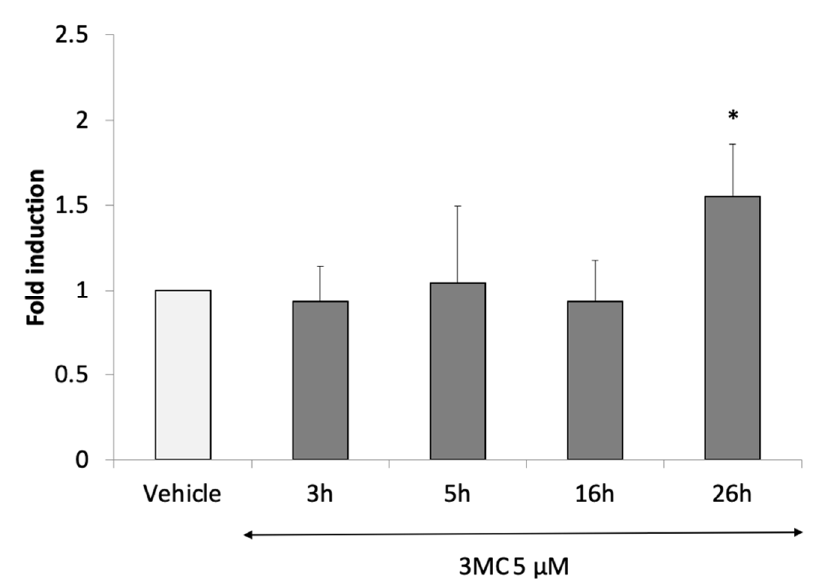
Figure 6. Time course of 3MC, a positive modulator of AHR-1 in Cos-7 cells. After transfection and culture for 24 h in 0% FBS medium, cells were treated for 24 h with 3-methylcholanthrene 5 µ M. After 3 h, 5 h, 16 h and 26 h of treatment, cells were lysed, and Firefly luciferase luminescence was read. Six independent experiments were performed in duplicate, error bars represent SD, fold induction is standardized to the vehicle which is 1. Statistical significances relative to the vehicle were examined: ANOVA with Bonferroni’s multiple comparison post ‐ test, * p ‐ value < 0.05.